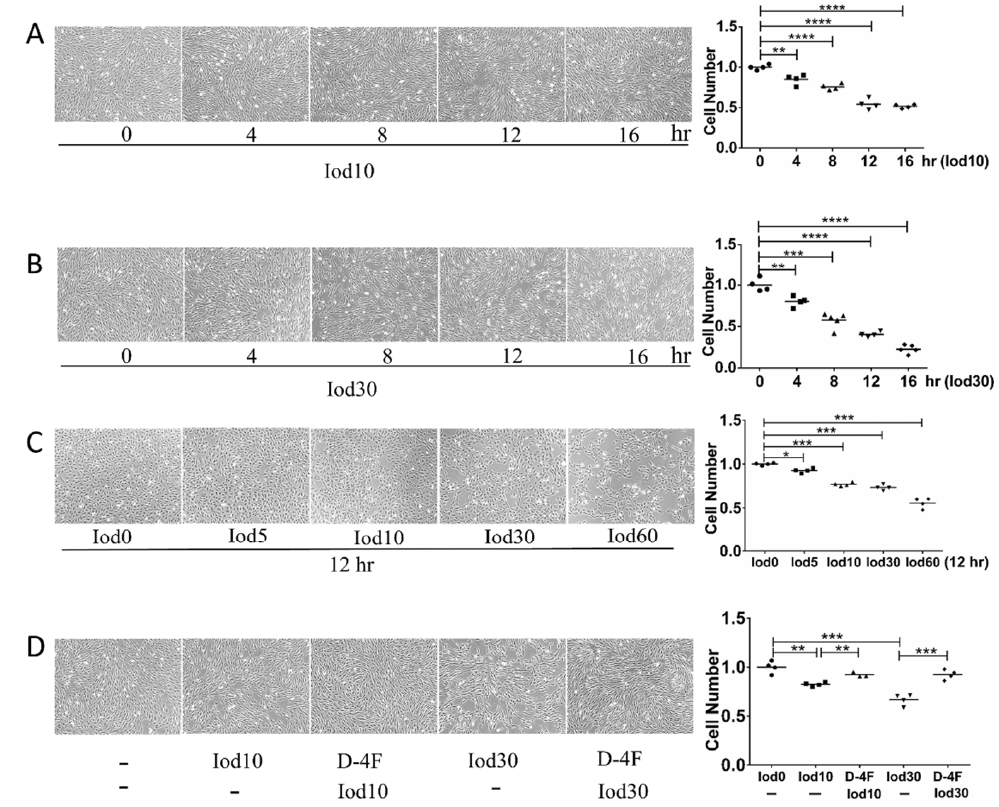
Figure 1. Cell vitality assay of HUVECs treated with iodixanol and D-4F. HUVECs were incubated with 10 or 30 mg I/mL of iodixanol for different time intervals ( A , B ), or with different doses of iodixanol for 12 h ( C ). Alternatively, HUVECs were pre-treated with or without 20 µ g/mL of D-4F for 8 h and then incubated with 10 or 30 mg I/mL for 12 h ( D ). Cell images were taken at 100× magnitude. (* p < 0.05; ** p < 0.01; *** p < 0.001; **** p < 0.0001. Circles represented group Iod0; boxes represented group Iod10; upright triangle represented group D-4F + Iod10; inverted triangle represented group Iod30; diamond represented group D-4F +